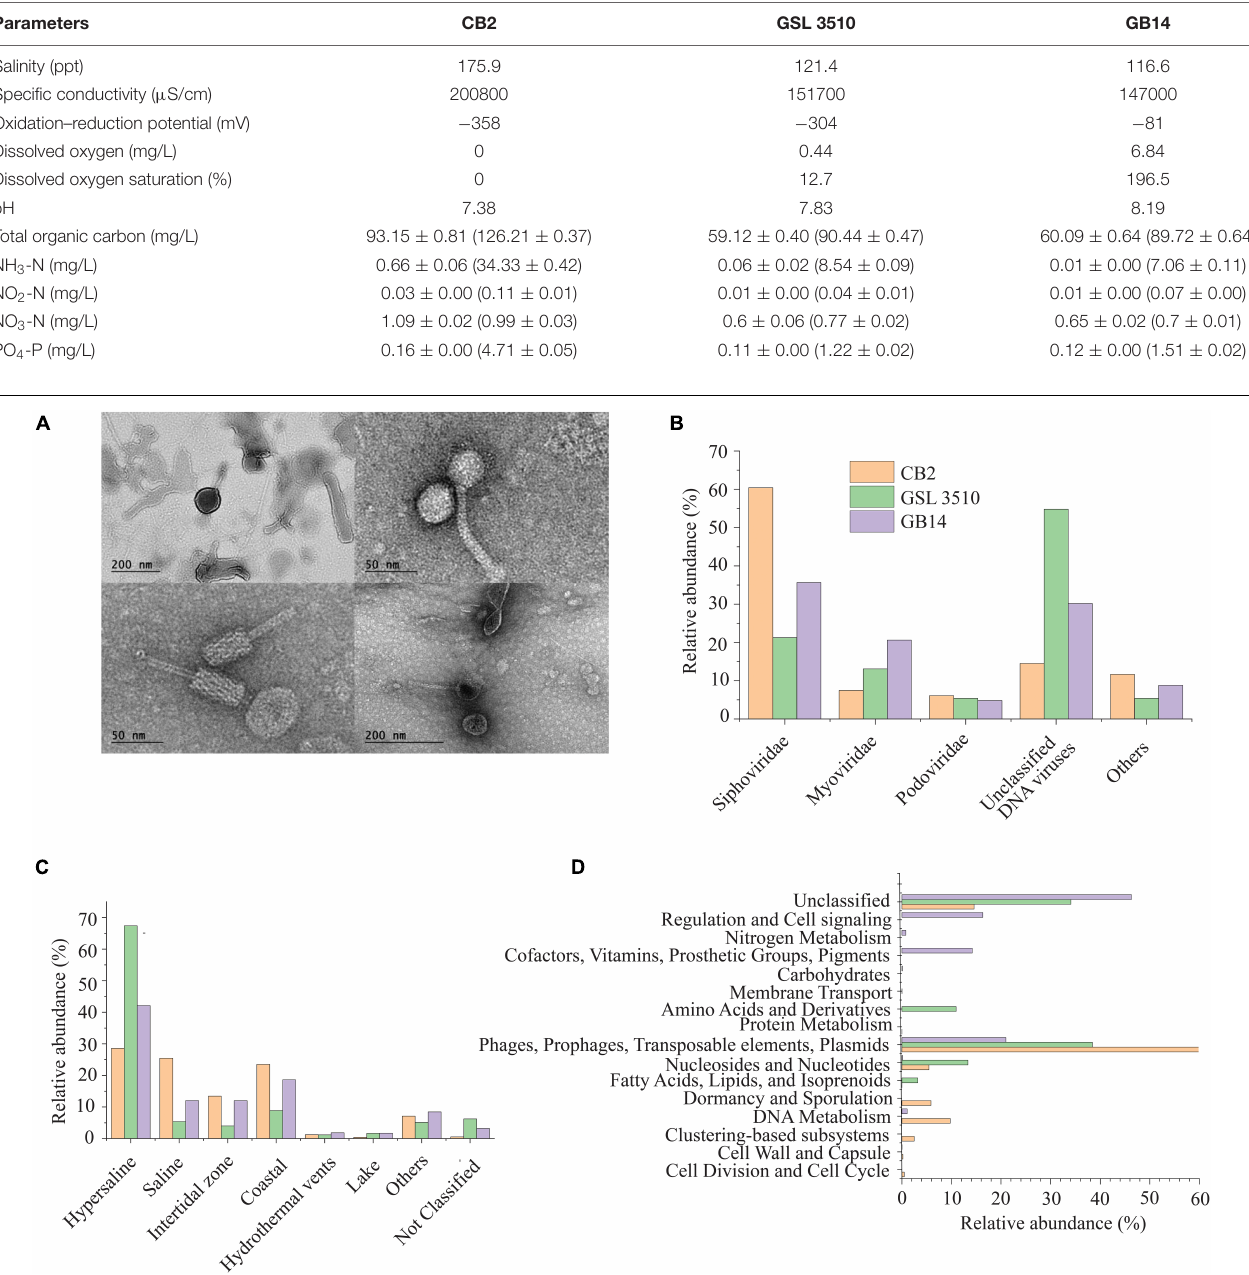
carbohydrates comprised 12.97 ± 2.15 and 11.34 ± 2.15% (mean ± SD), respectively, of the genes. Genes